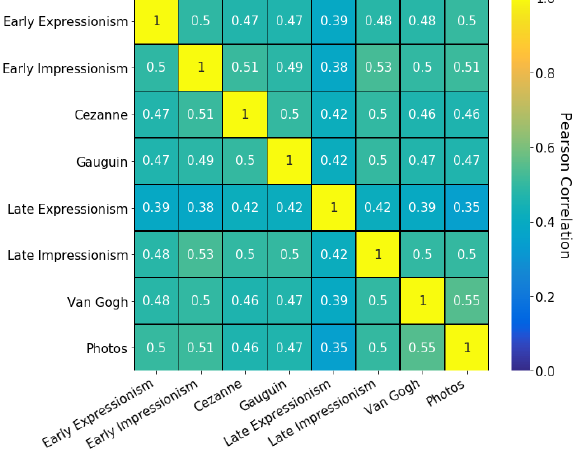
Figure 15: Correlation matrix of fixations on all images in the eight different styles.